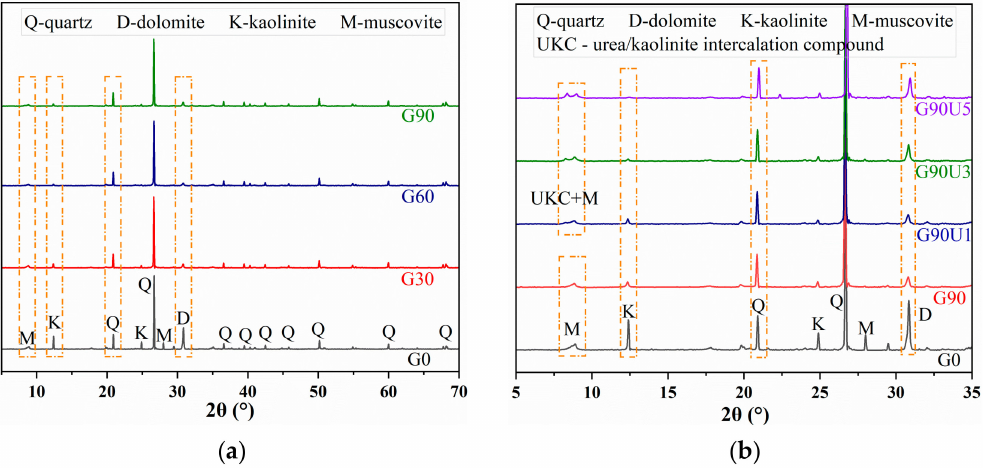
Figure 4. XRD spectra of Gx ( a ) and GxUy ( b